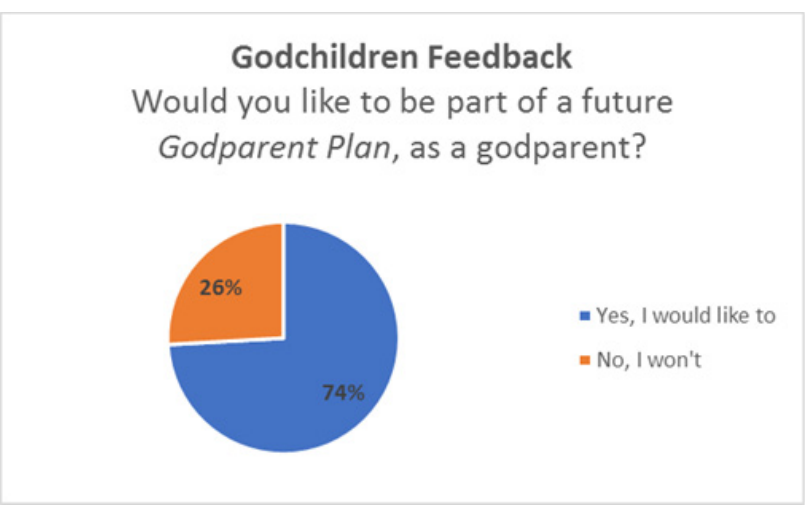
Fig. 7. Godchildren’ interest towards being godparents in a future Godparent